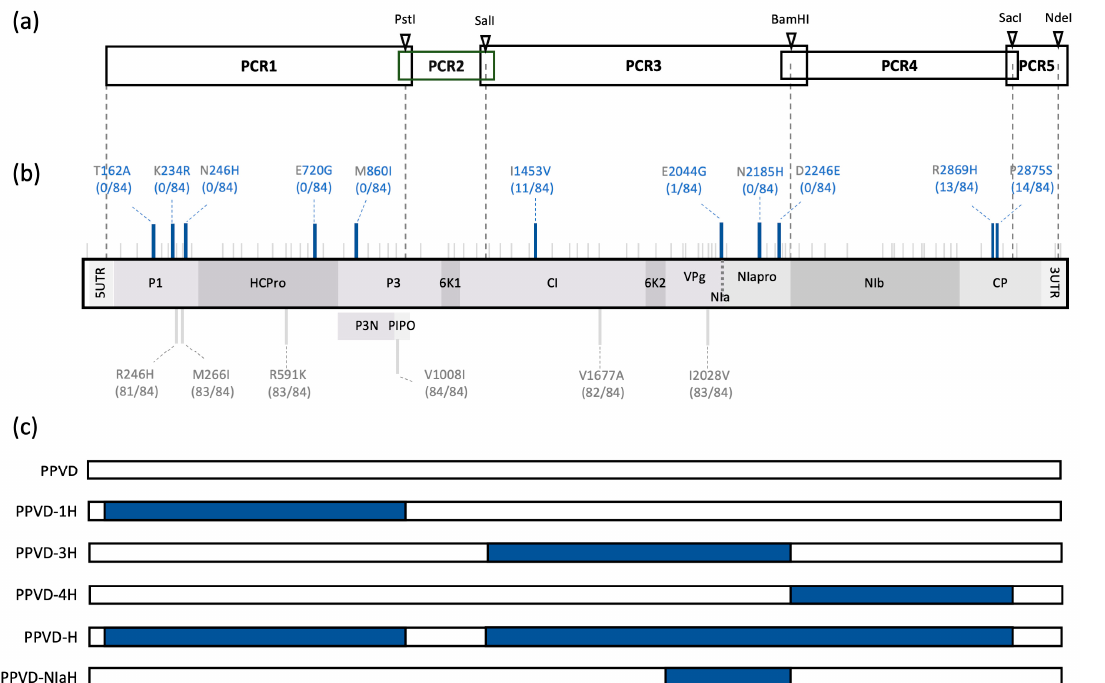
Figure 1. Cloning of PPVD-H and its comparison with other PPV-D isolates. ( a ) Schematic representation of different PCR products amplified for the cloning of PPVD-H. Unique restriction sites present in the PPV sequence are marked with triangles. ( b ) Differences observed between PPVD-H and the standard PPVD isolate. Nucleotide changes are shown on top of the genome as small gray lines; amino acid changes are shown as large lines: common changes are depicted in gray below the genome and rare changes are depicted in blue on top of the genome; amino acid number is indicated, as well as its identity in the two variants PPVD (left) and PPVD-H (right); number of times the amino acid of PPVD-H appears in the 84 PPV-D isolates of SharCo Database is shown in parenthesis. ( c ) Scheme of the viral chimeras generated for characterization of PPVD-H isolate; PPVD and PPVD-H sequences are shown in white and in blue, respectively.